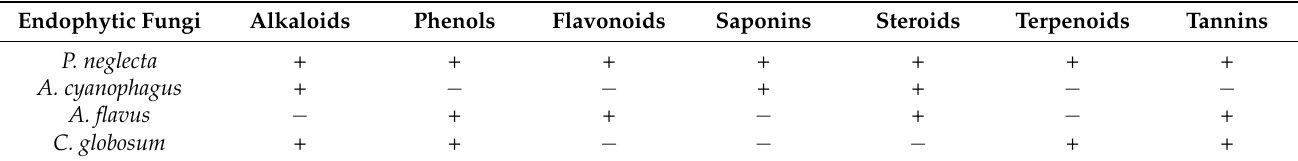
Table 3. Phytochemical activity screening of crude extracts from endophytic fungi isolated from Z. spina-christi